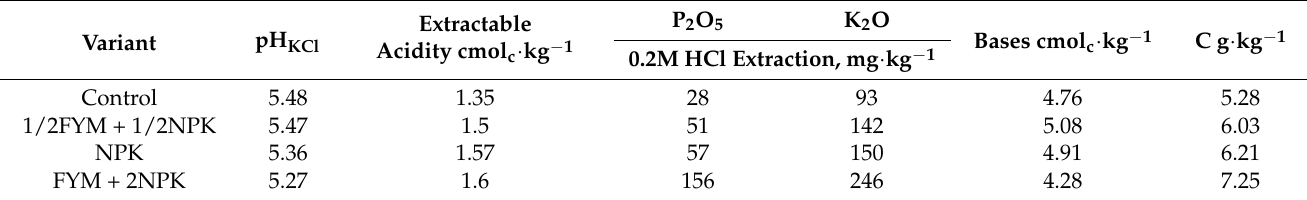
Table 2. Agrochemical characteristics of the soil at the end of the 11th grain crop rotation, 2018. Variant pH KCl